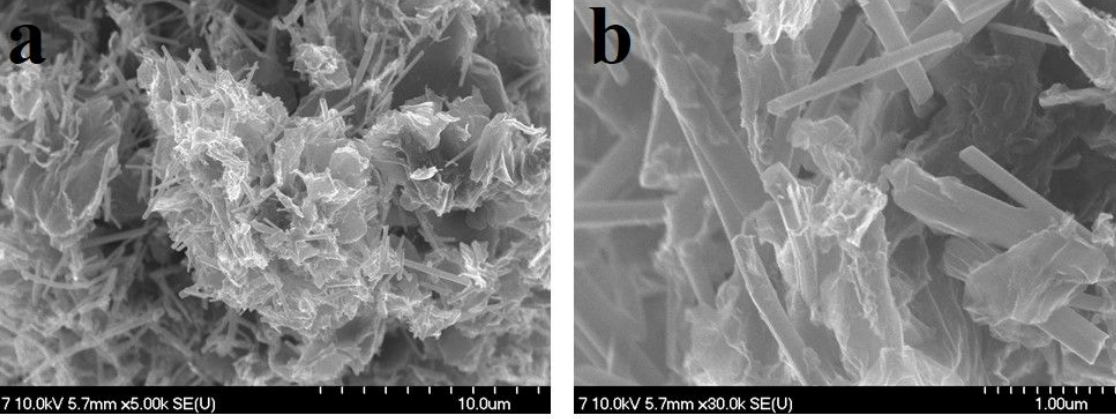
Figure 3: (a) low and (b) high magnification FE-SEM images of the synthesized Se-nanorods/rGO